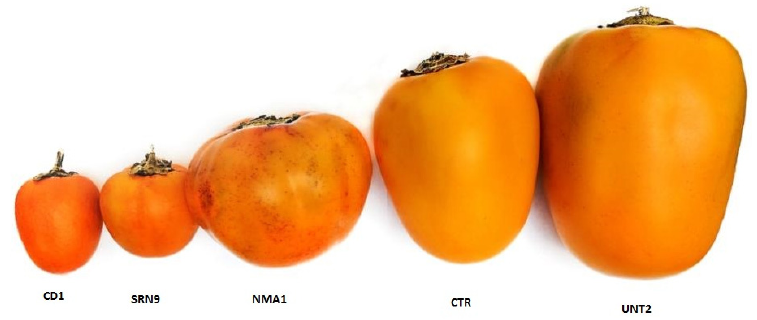
Figure 1. Pictures of cocona fruits NMA1, SRN9, CD1, CTR, UNT2 ecotypes.